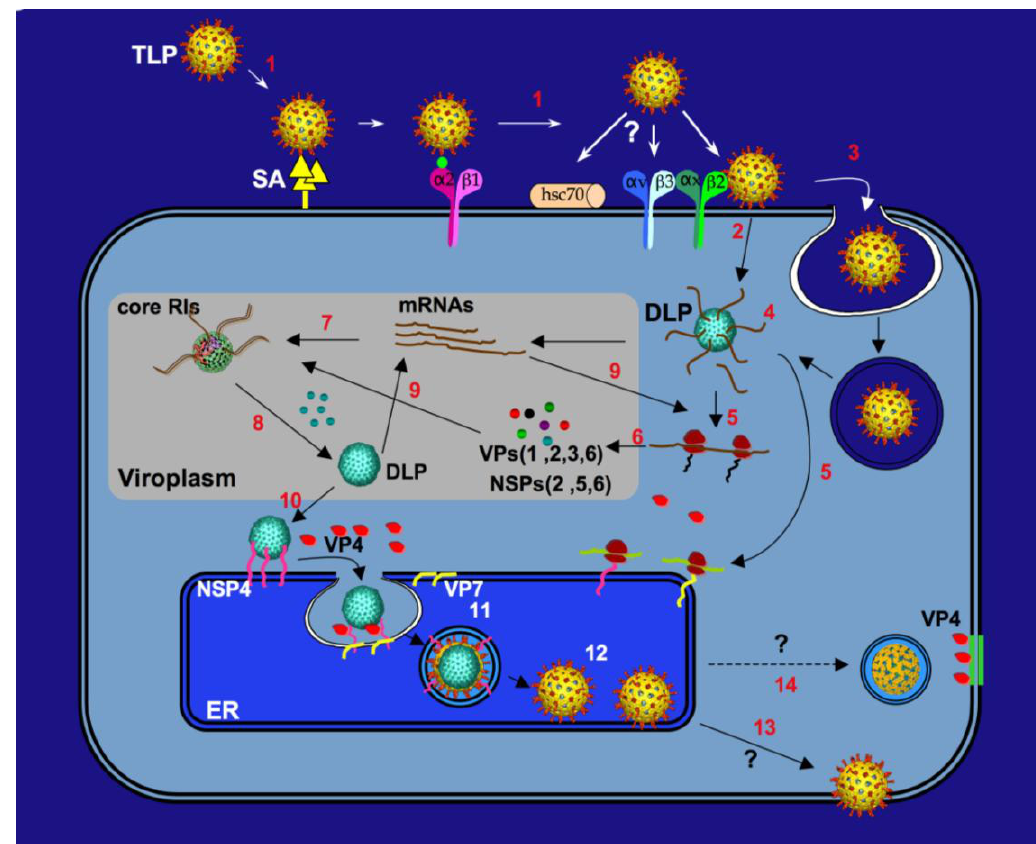
FIGURE 5 . Schematic representation of the steps of rotavirus replication. (1) Trypsinized TLP binds to one or more receptors on cell surface. (2) Conformational changes on virus permitting penetration by a direct route to the cytoplasm, or (3) by Ca 2+ - dependent endocytosis. (4) Solubilization of the outer protein layer generating DLP that reaches the cytoplasm; activation of transcriptase in DLP and synthesis of mRNA. (5) Translation of mRNA in polysomes and ER-bound ribosomes; synthesis of viral proteins. (6) Accumulation of viral proteins and mRNA, and nucleation of viroplasm. (7) Assembly of core replication intermediates (core RIs) and (–) RNA synthesis. (8) Assembly of DLP. (9) Secondary transcription from DLP and amplification of protein synthesis. (10) Binding of DLP to NSP4 and budding into the ER. (11) Acquisition of the membrane envelope together with VP7, NSP4, and perhaps VP4. (12) Removal of membrane lipids and NSP4, and accumulation of mature TLP. (13) Release of viral progeny through cell lysis or, alternatively, by (14) traffic of immature TLP (without VP4) to rafts containing VP4, and acquisition of VP4 and eventual release at apical membrane without